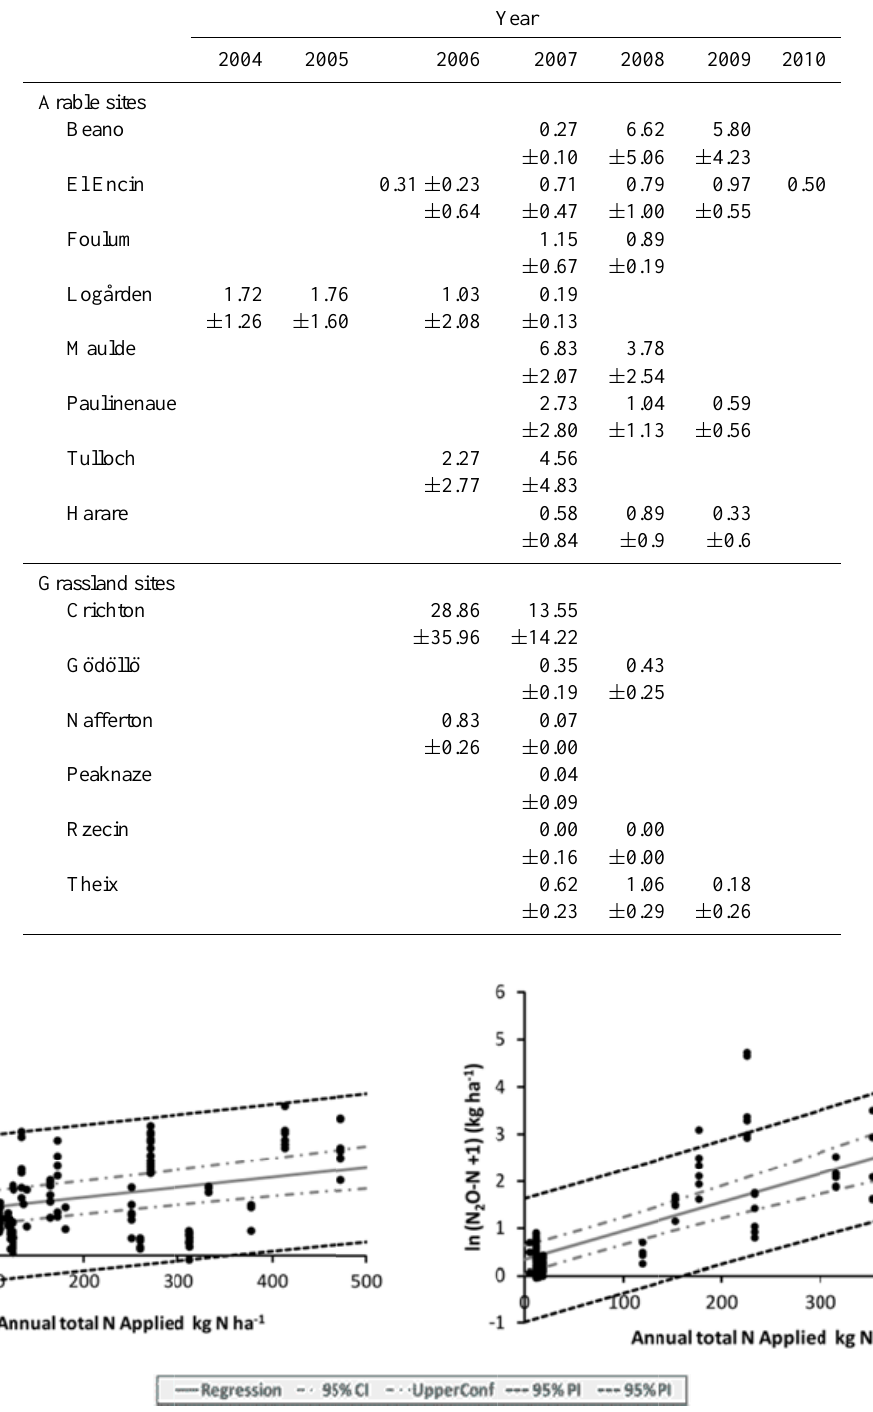
Table 4 . Nitrous oxide emissions in response to site and management conditions across the experimental network classified by site and year